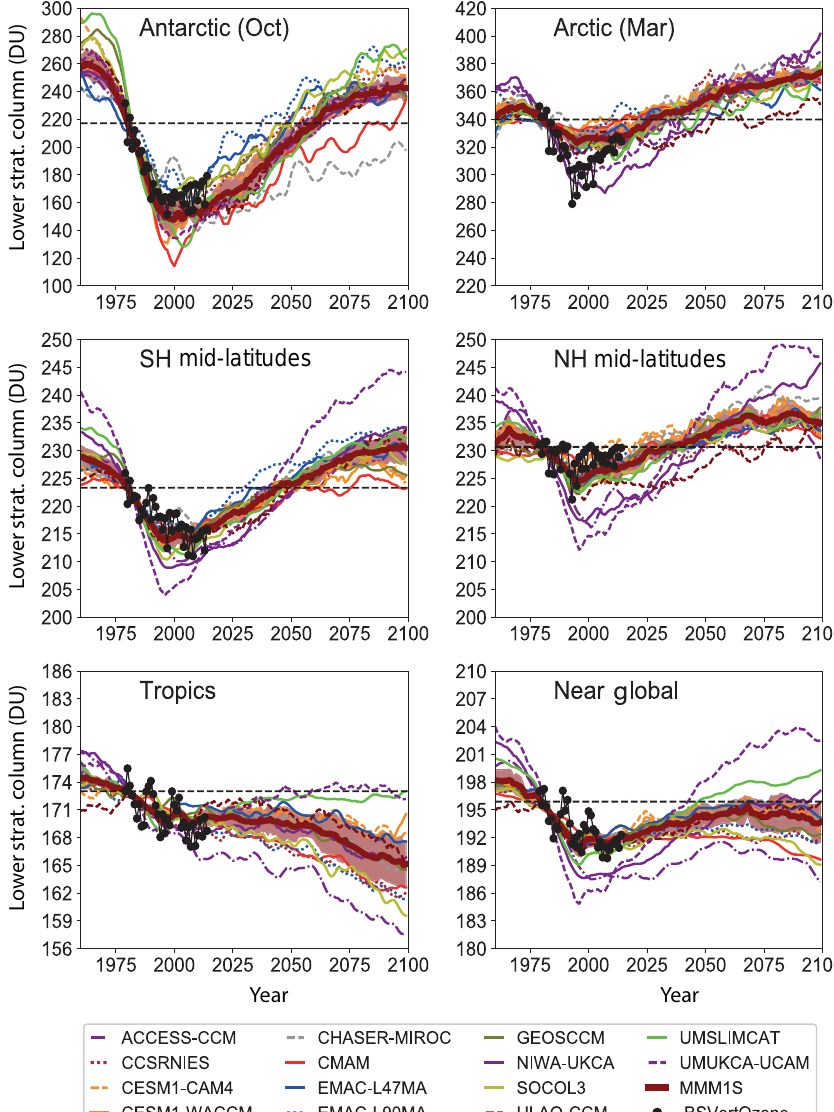
Figure 5. Evolution of partial column ozone (DU) for the lower stratosphere (tropopause – 10hPa) from the REF-C2 simulations from 14 individual models, along with the MMM1S. Also shown are estimates of the partial column from the Bodeker Scientific Vertical Ozone (BSVertOzone) database, which is based on a compilation of satellite, balloon, and ground-based measurements (Bodeker et al.,